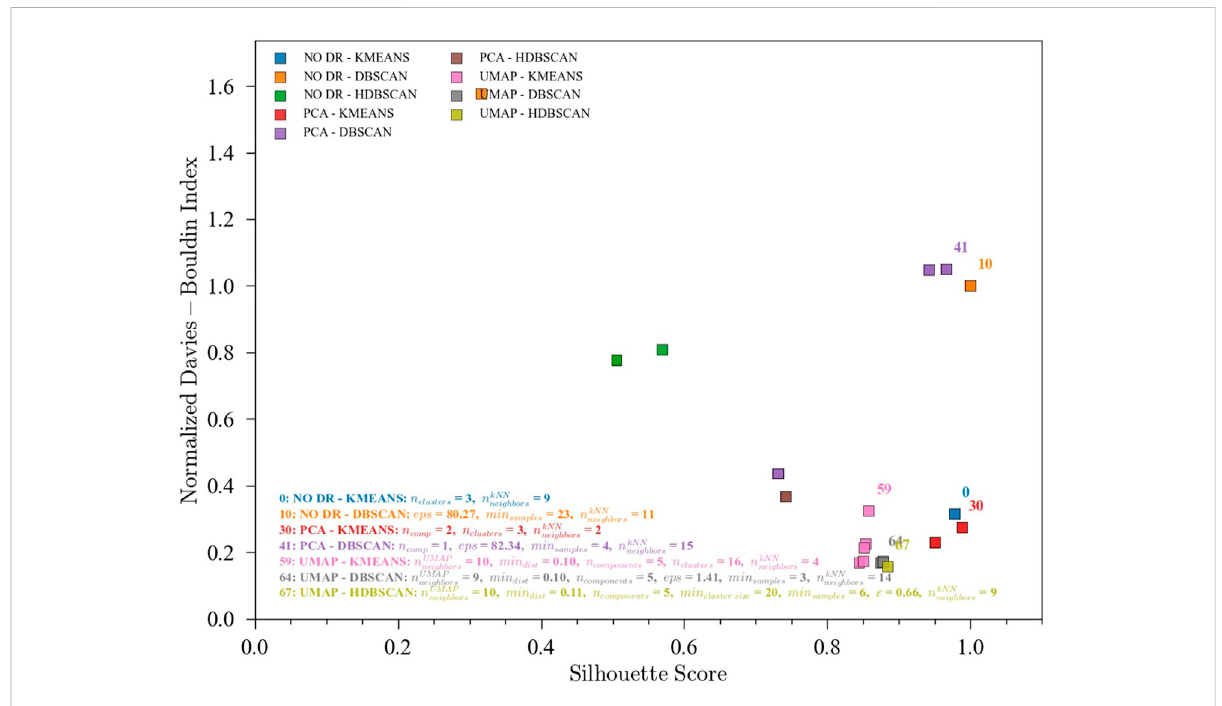
FIGURE 9 Pareto fronts for the unsupervised multi-objective (S-score and DBI) optimization of the ensembles. Data from the pyrolysis reactor without labels. (0) NO DR-KMEANS, n clusters (cid:1) 3, n kNN neighbors (cid:1) 9; (10) NO DR-DBSCAN, eps (cid:1) 80 . 27, min samples (cid:1) 23, n kNN neighbors (cid:1) 11; (30) PCA-KMEANS, n components (cid:1) 2, n clusters (cid:1) 3, n kNN neighbors (cid:1) 2; (41) PCA-DBSCAN, n components (cid:1) 1, eps (cid:1) 82 . 34, min samples (cid:1) 4, n kNN neighbors (cid:1) 15; (59) UMAP-KMEANS, n UMAP neighbors (cid:1) 10, min dist (cid:1) 0 . 10, n components (cid:1) 5, n clusters (cid:1) 16, n kNN neighbors (cid:1) 4; (64) UMAP-DBSCAN, n UMAP neighbors (cid:1) 9, min dist (cid:1) 0 . 1, n components (cid:1) 5, eps (cid:1) 1 . 41, min samples (cid:1) 3, n kNN neighbors (cid:1) 14; (67) UMAP-HDBSCAN, n UMAP neighbors (cid:1) 10, min dist (cid:1) 0 . 11, n components (cid:1) 5, min cluster size (cid:1) 20, min samples (cid:1) 6, (cid:1) 9. ε (cid:1) 0 . 66, n kNN neighbors